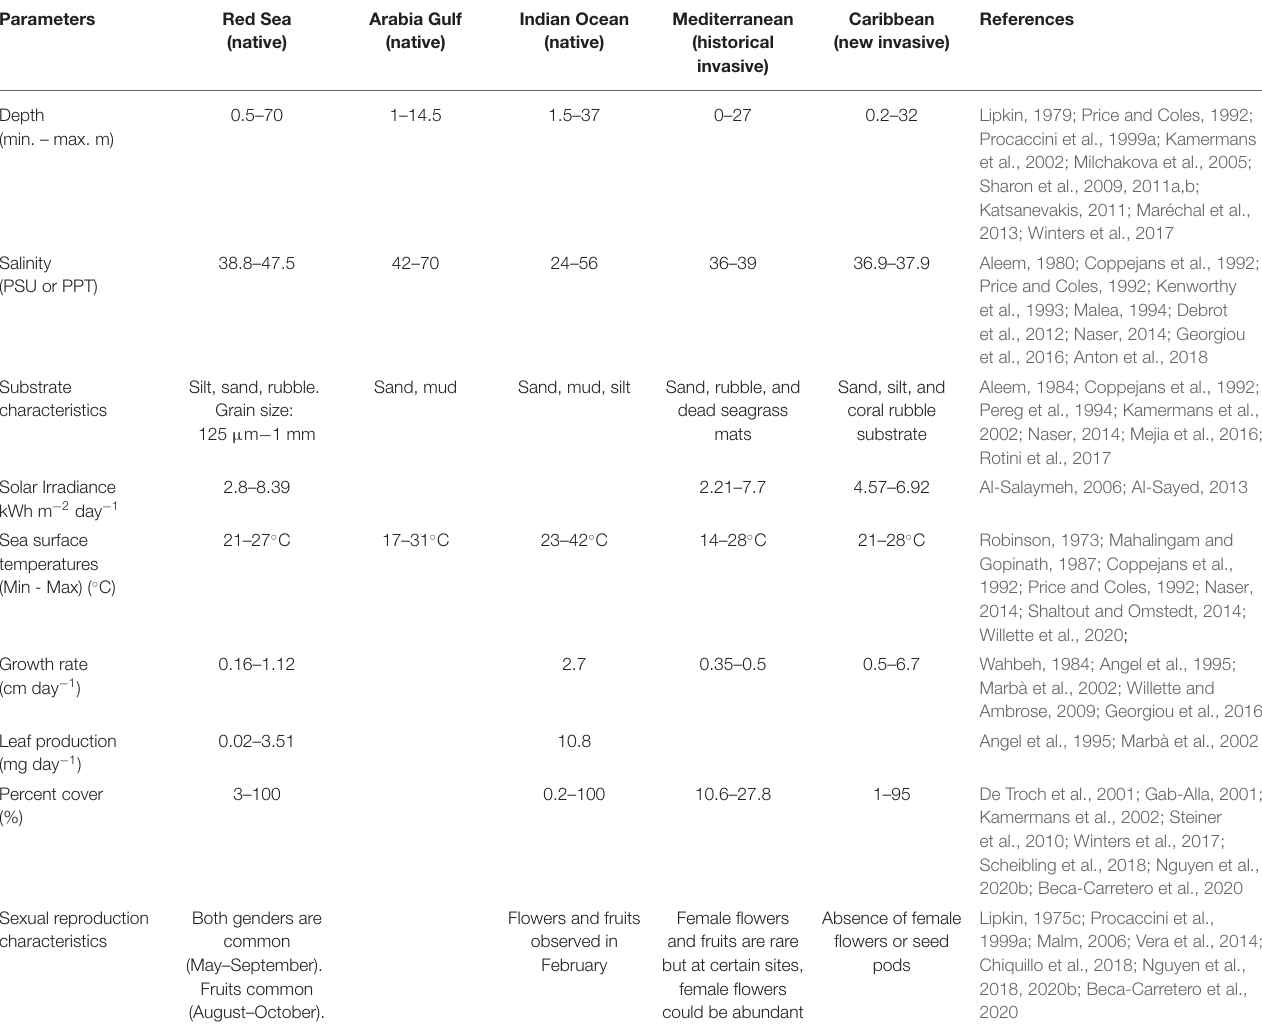
TABLE 1 | Summary of main environmental and ecological parameters published for Halophila stipulacea across its entire distribution (see Table S1 for full details).